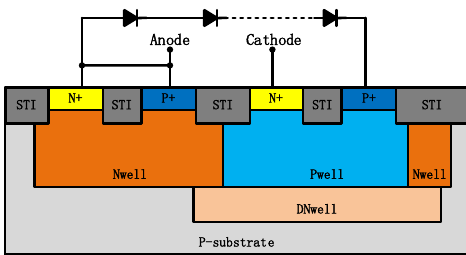
Figure 6. Schematic cross-section of the measured DTSCR.